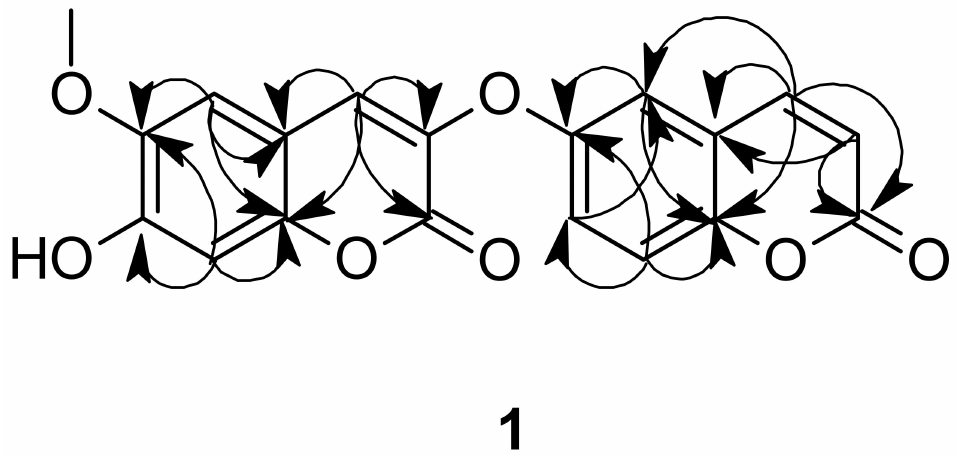
Figure 2. Key HMBC correlations of jusan coumarin.